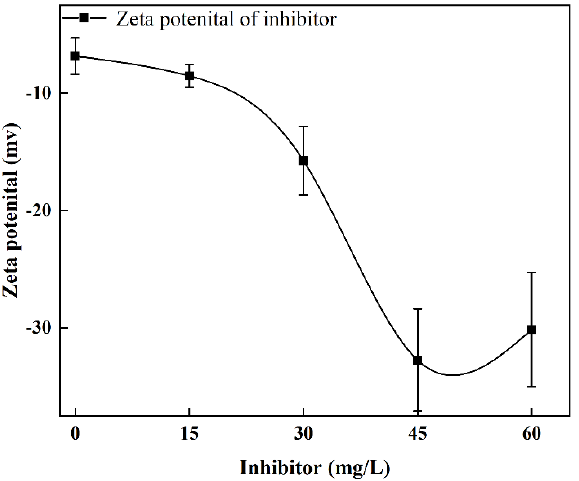
Figure 8. Zeta potential change under different inhibitor dosages.